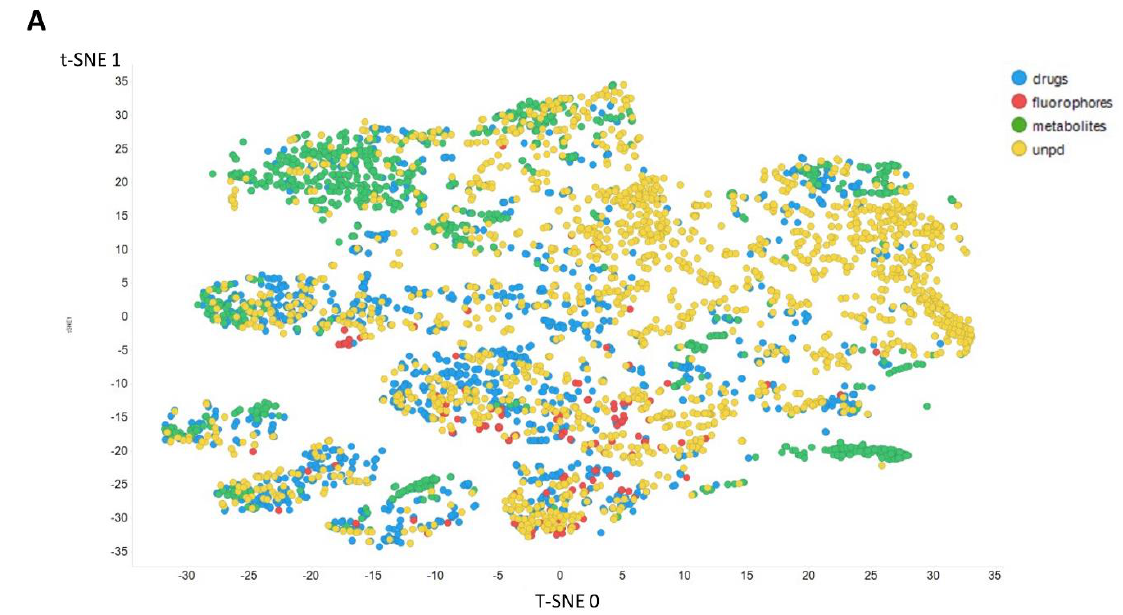
Figure 2. Learning curve for training our transformers on ( A ) drugs, metabolites, fluorophores, and 2000 natural products, and ( B ) a full set of natural products. Because the transformer is effectively a one-shot learner, and the batch size varied, the abscissa is shown as a single epoch. The batch size was varied, as described in Section 4, and was ( A ) 50 (latent space of 64 dimensions) and ( B ) 20 (latent space of 256 dimensions), leading to an actual number of batches of ( A ) 92 and ( B )